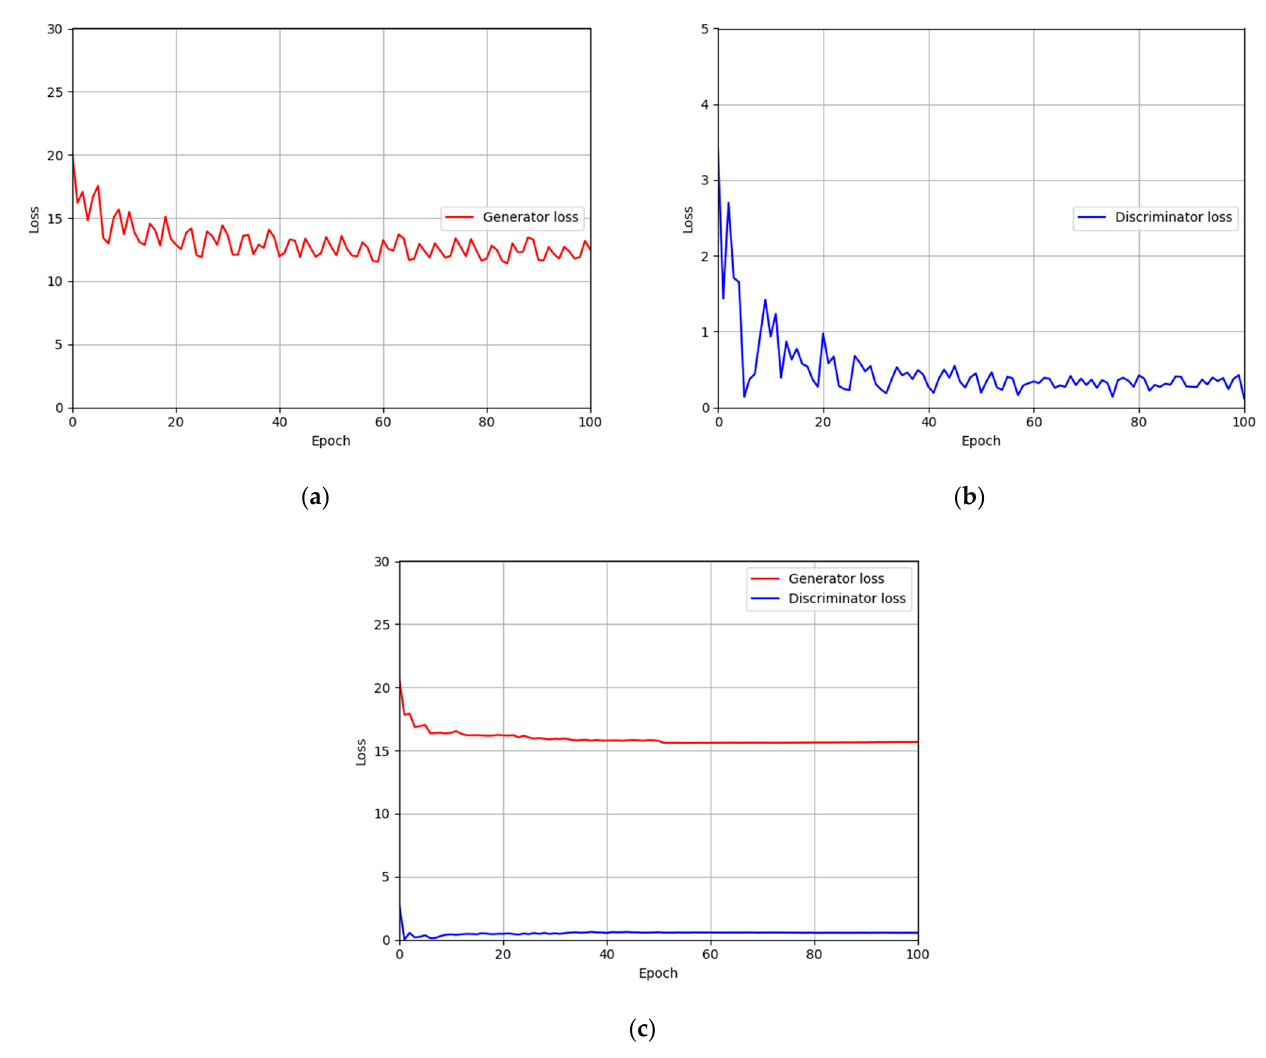
Figure 11. Training and validation loss graphs of the modified DeblurGAN (SDU-DB): training loss graphs of ( a ) generator and ( b ) discriminator. ( c ) Validation loss graphs of generator and